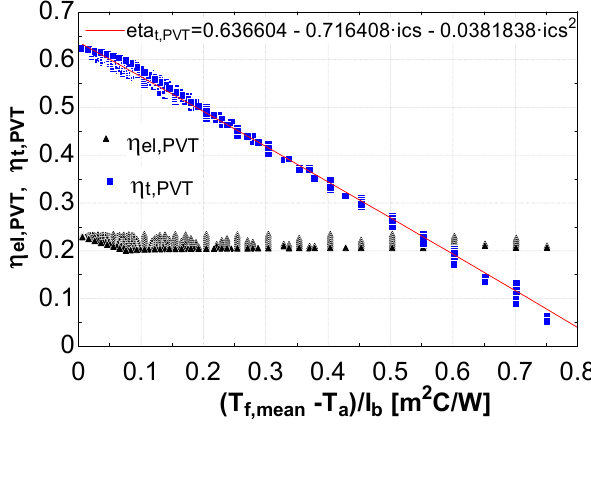
Figure 2. CPVT electrical and thermal